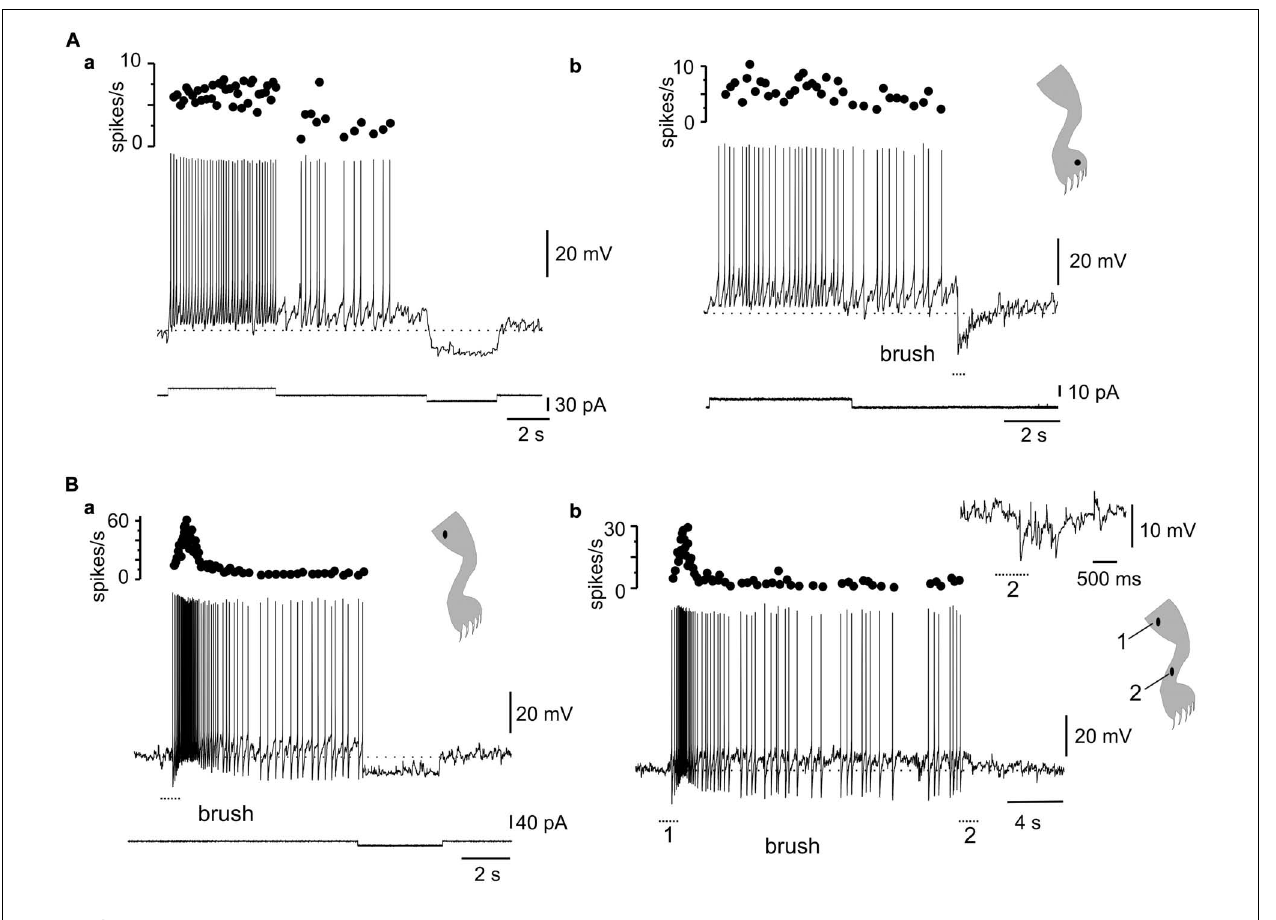
response with incrementing firing frequency followed by an after-discharge terminated by a mild hyperpolarizing current pulse (a) . A similar behavior could be produced by alternate stimulation on spots within the excitatory (1) and inhibitory (2) receptive fields (b) .The inset in (b) shows the response to brush on a spot within the inhibitory receptive field. (A,B) From two different